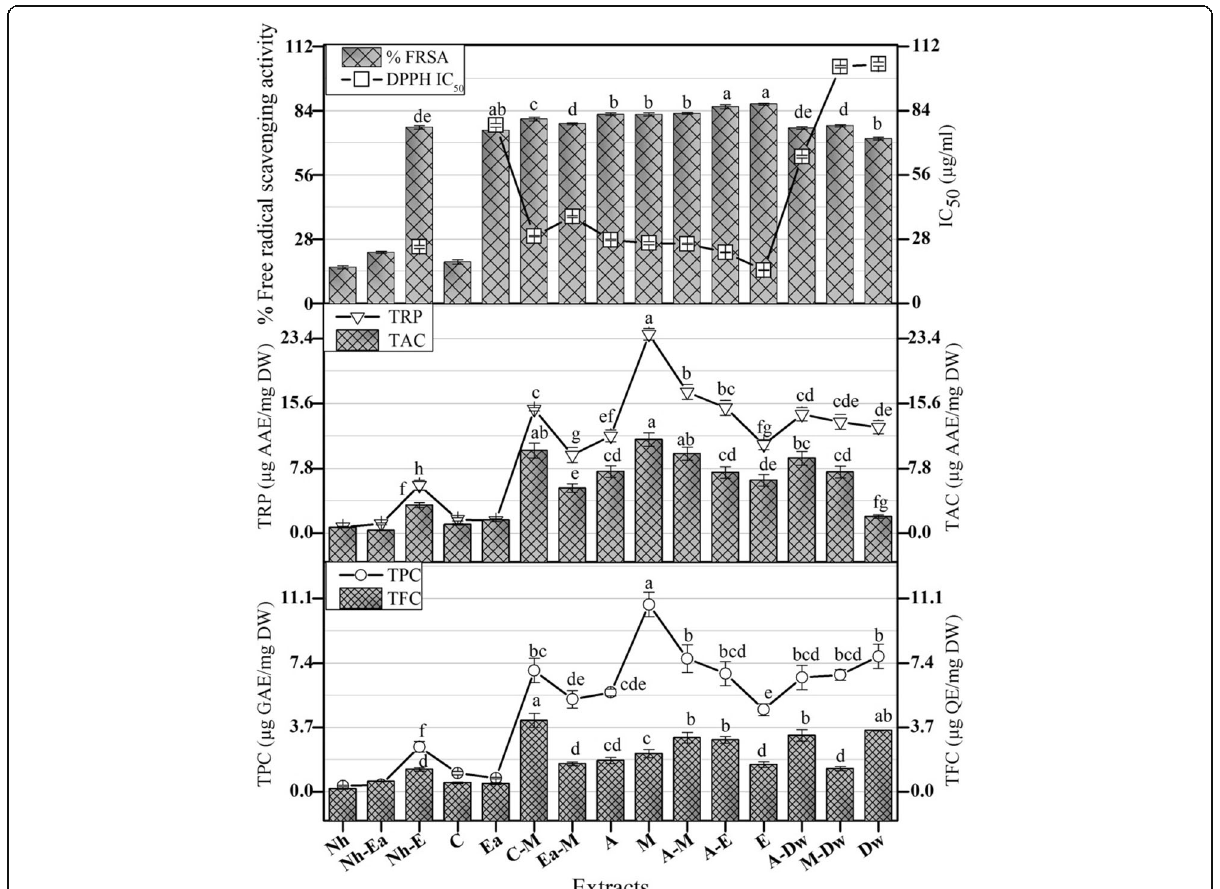
Fig. 2 Total phenolic content ( μ g GAE/mg DW), total flavonoid content ( μ g QE/mg DW), total reducing power ( μ g AAE/mg DW), total antioxidant capacity ( μ g AAE/mg DW) and free radical scavenging activity (%) of A. bracteosa in different extracts. IC 50 of ascorbic acid is found to be 21.8 μ g/ml. Values are presented as mean ± Standard deviation ( n = 3). The columns with different superscript ( a-g ) letters show